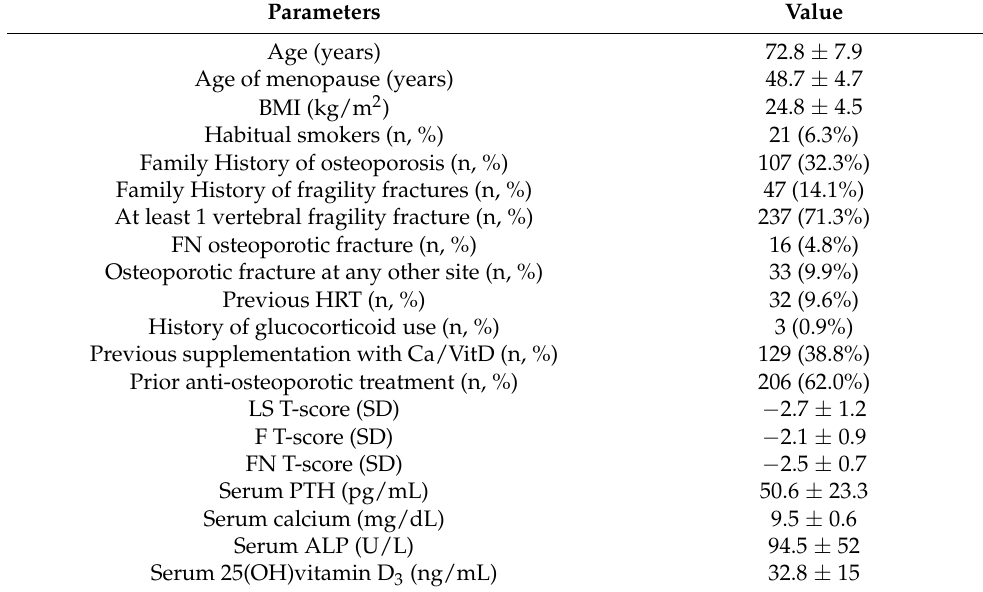
Table 1. Study population characteristics at baseline (before denosumab